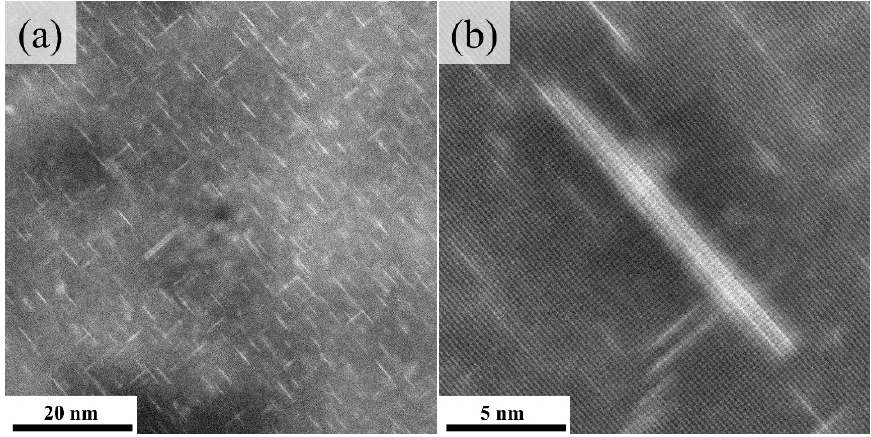
Figure 6. HAADF-STEM images of P80A-120 sample. ( a ) Low-magnification image. ( b ) High-reso- lution image. The electron beam is parallel to [001] Al direction. resolution image. The electron beam is parallel to {001} Al